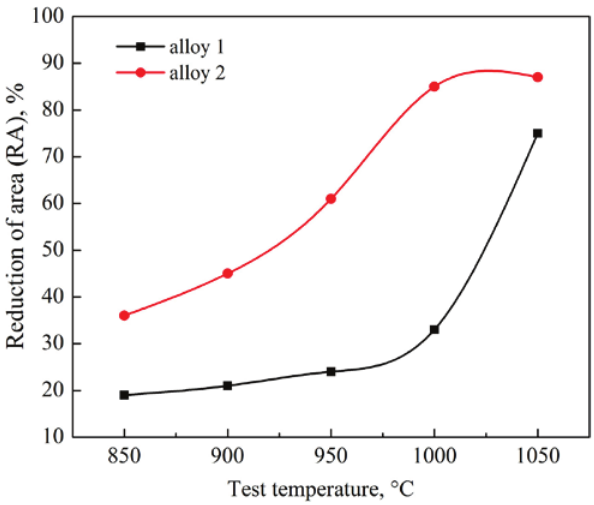
Fig. 1: Hot ductility curves of both tested